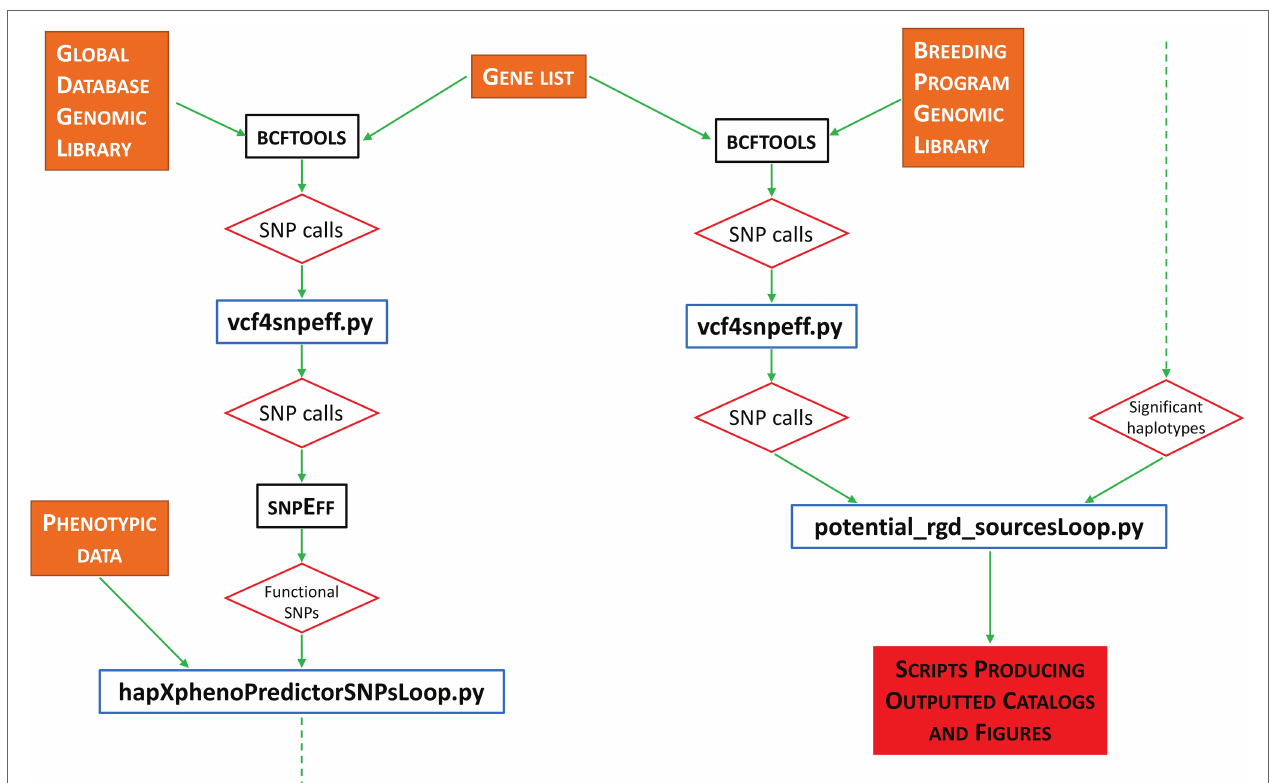
FIGURE 1 | Flowchart representation of workflow performed by the rice E xplorer bioinformatics pipeline. Orange filled boxes represent data inputs; black bordered boxes represent publicly available, previously published software integrated into the workflow; blue bordered boxes represent custom-made P ython programs developed for this pipeline; red bordered diamonds represent program/workflow outputs; red-filled box indicates final outputs via scripts developed to automate figure production; dashed green arrows indicate continued flow from bottom to